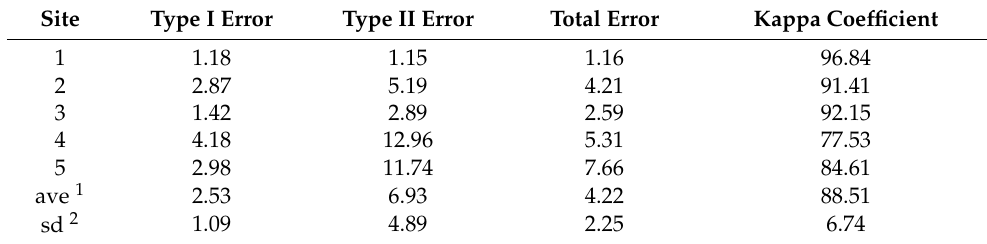
Table 4. Errors and kappa coefficients of the proposed method in all sites (%).